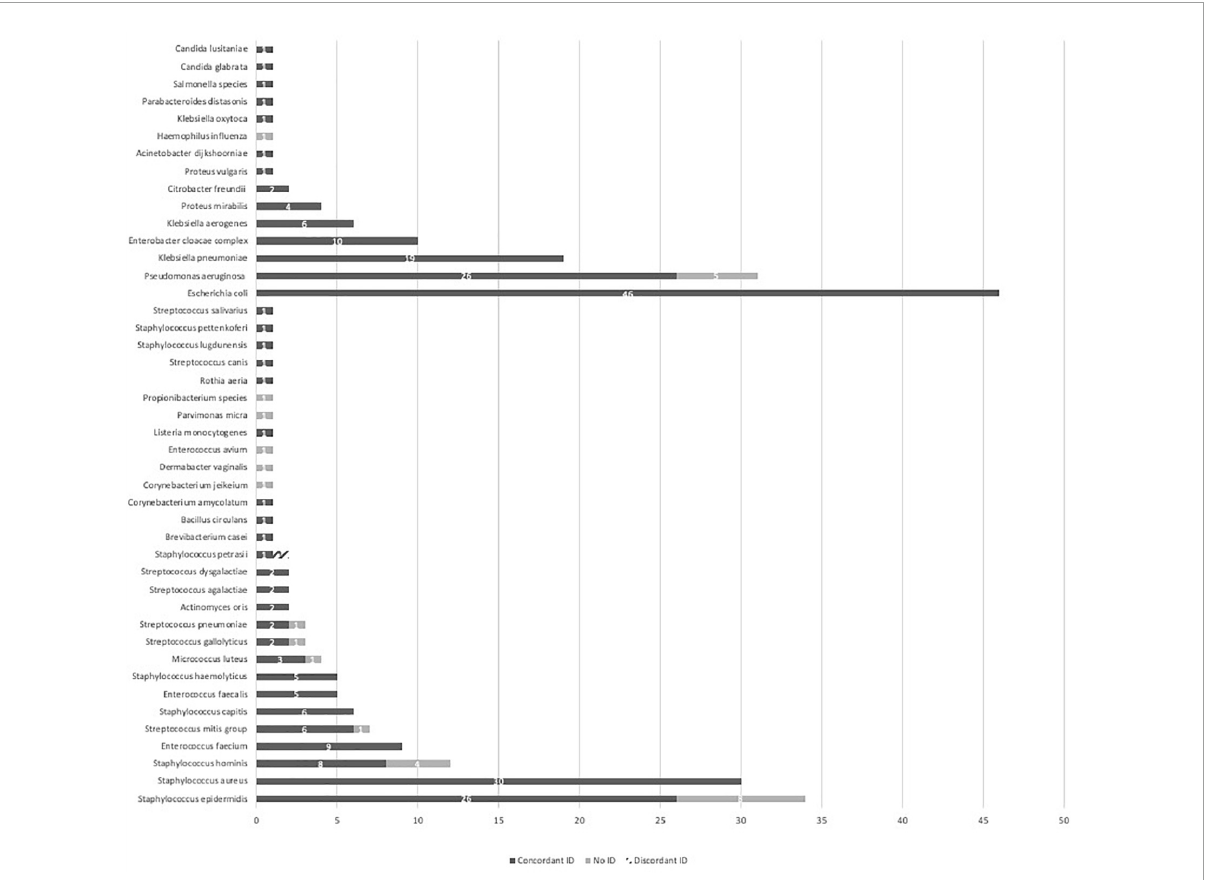
FIGURE2 MALDI-TOF MS identification performances from a liquid colony following FAST TM System testing on positive blood cultures in both study arms. ID, identification; MALDI-TOF MS, matrix-assisted laser desorption ionization time-of-flight mass spectrometry.